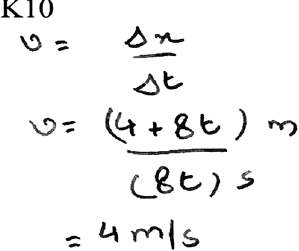
FIG. 11. Example of case 3 with question K10 in which equation x ¼ 4 þ 8 t was provided: a unit-based interval or point confusion in which the equation of motion and a term in the equation are thought to be expressed in units of meters and units of seconds, respectively.